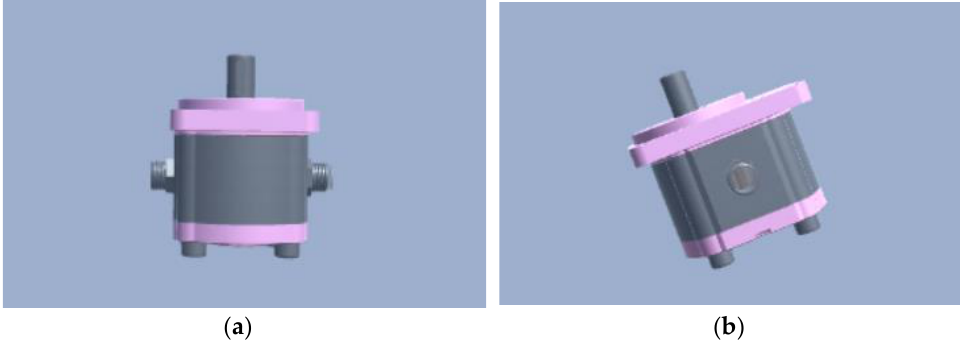
Figure 7. Rotation of the external gear pump: ( a ) Before rotation. ( b ) After rotation.